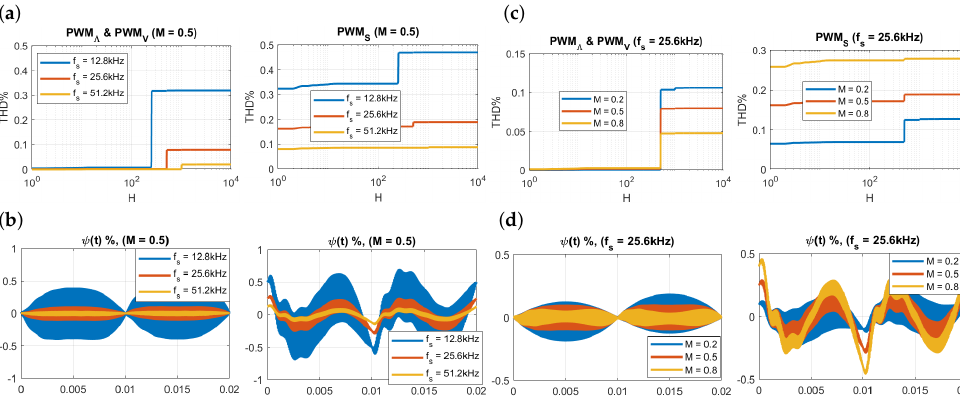
Figure 8. Dependence of ψ ( t ) and THD H from f s and M in the no-load open loop PWM V and PWM S controlled system. ( a , b ): ψ ( t ) ; M = 0.5, f s = 12.8, 25.6 and 51.2 kHz, ( c , d ): ψ ( t ) ; f s = 25.6 kHz, M = 0.2, 0.5, 0.8.